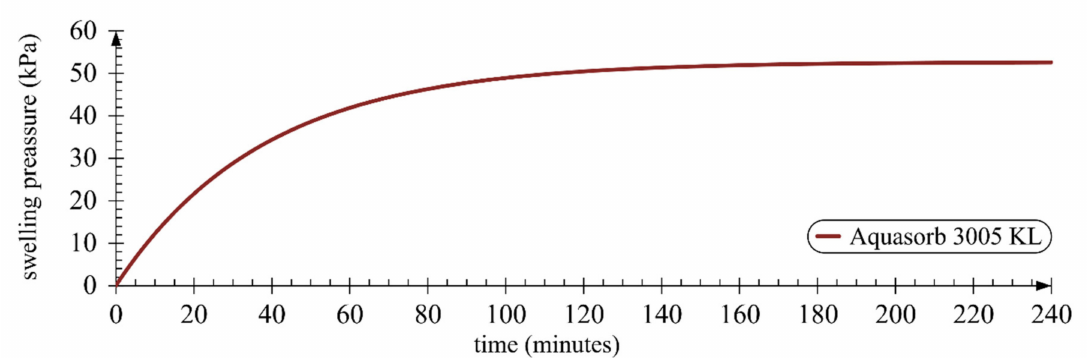
Figure 9. Theoretical swelling pressure for loamy sand soil (sand 83%, silt 10%, clay 7%) in a topsoil layer characterised by soil bulk density of 2.0 g · cm − 3 and the superabsorbent polymer Aquasorb 3005 KL in the amount of 0.7% in the first cycle of swelling. The curve was drawn according to the model by Misiewicz et al.